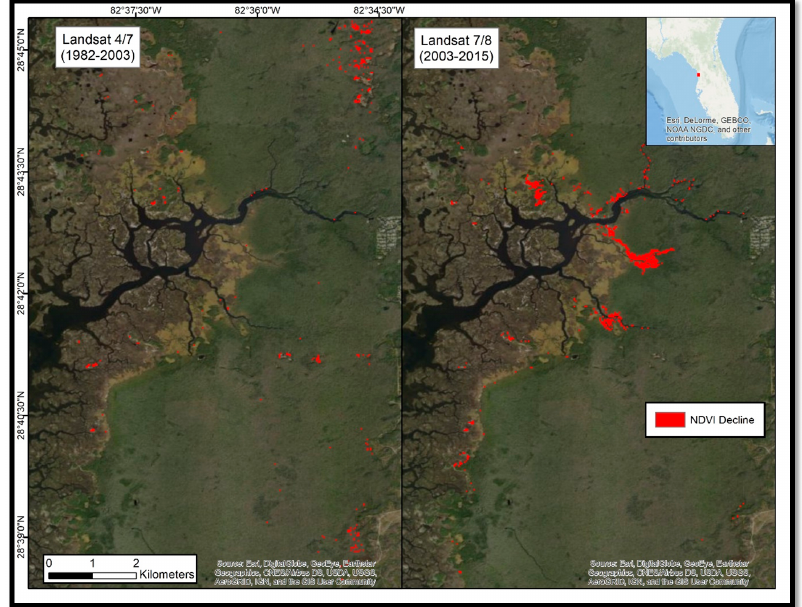
Figure 5. Decline in coastal forest normalized difference vegetation index (NDVI) (< − 0.05) from Landsat series, shown in red, for 1982–2003 ( left ) and 2003–2015 ( right ; background map source: ArcGIS ® basemaps).